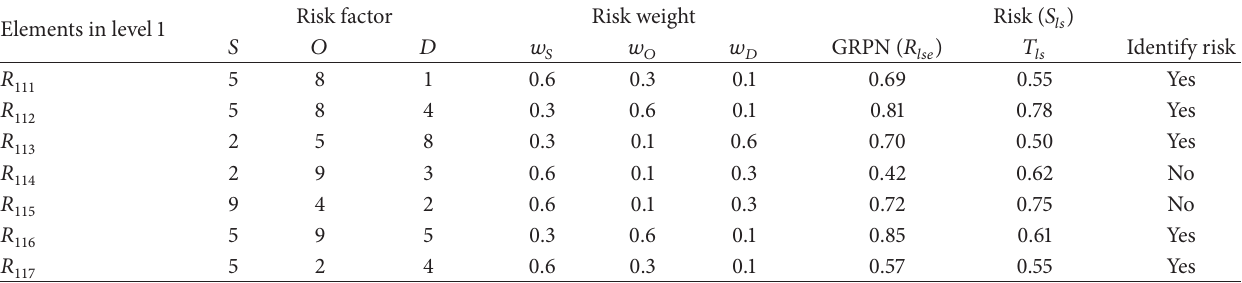
Table 16: Adaptive risk identification with scenario of risk weight threshold: hetero-hetero. Elements in level